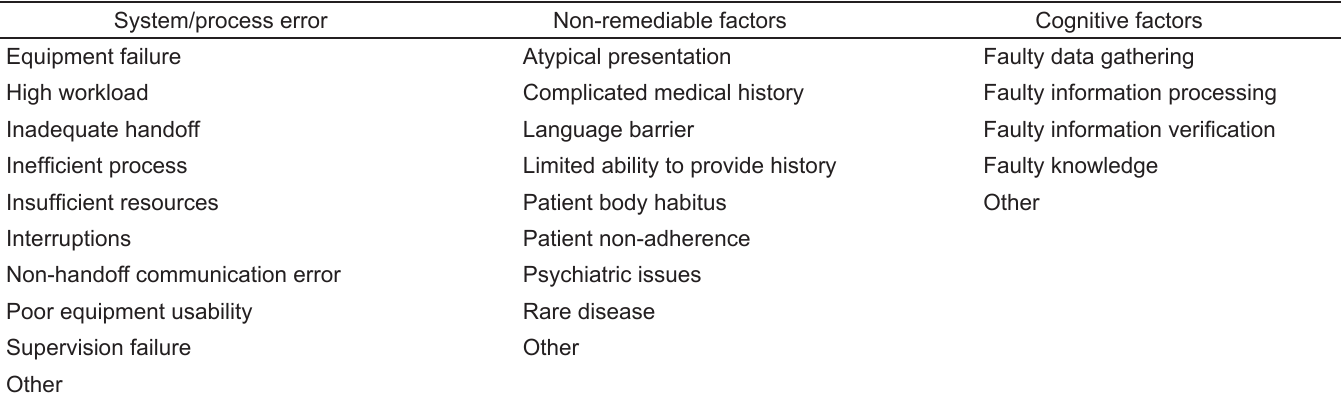
Table 7. Example of an error taxonomy system. 52